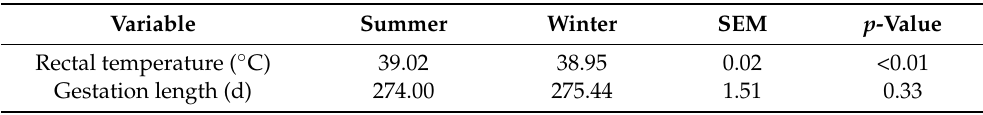
Figure 1. Late gestation average temperature–humidity index (THI) during summer and winter. The dashed line represents the THI threshold (68) when cows start to experience the effect of heat stress [25]. Table 2. Rectal temperatures and gestation length from dairy cows during summer ( n = 28) or winter ( n = 23) during late gestation.